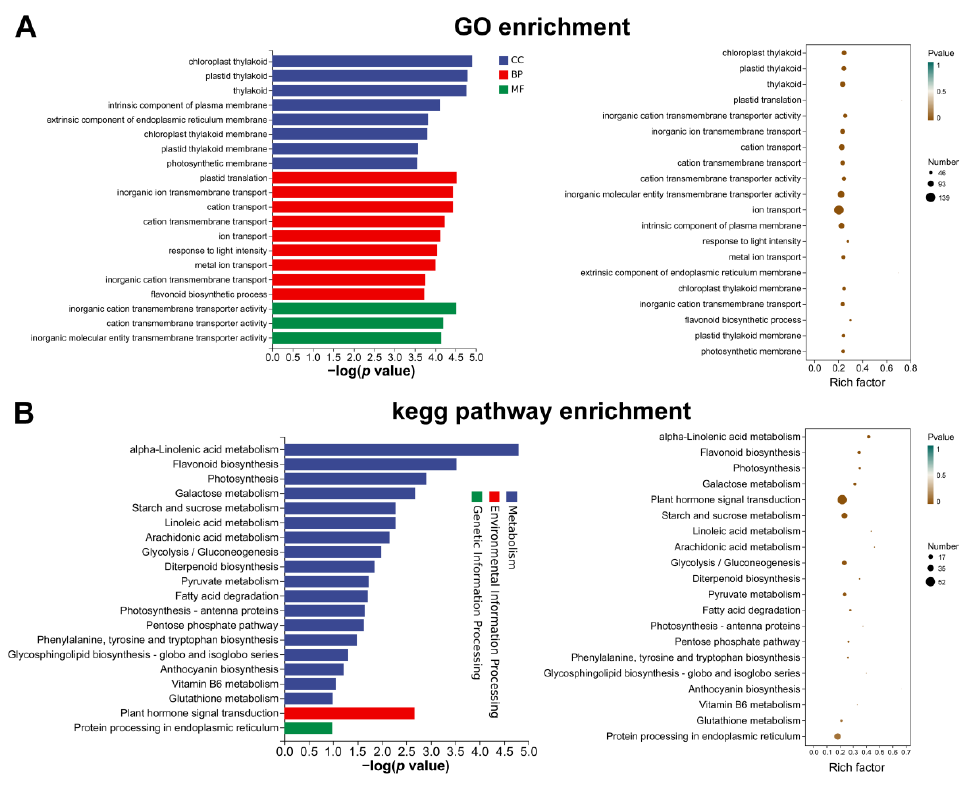
Figure 5. GO ( A ) and KEGG ( B ) results of the top-20 enriched genes monitoring the anthocyanin abundance in the fruit of ZJ at 27 DAF compared to ZZB.